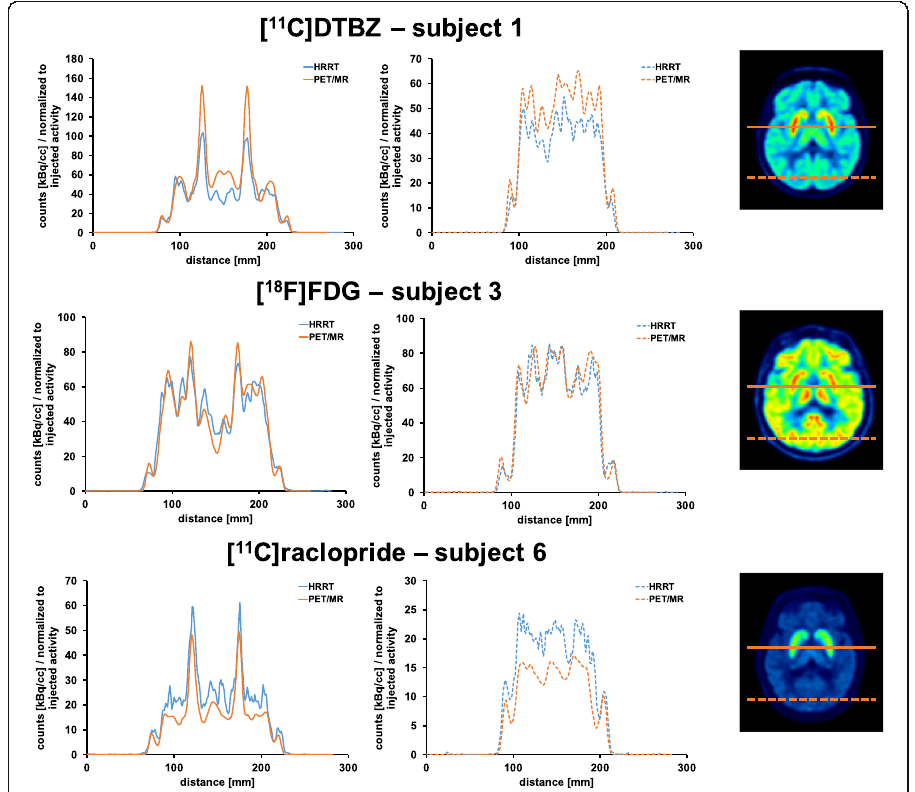
Fig. 8 Line profiles ([ 11 C]DTBZ, [ 18 F]FDG, [ 11 C]raclopride) of mean PET images. Profiles were normalized to the injected activity of each subject. Position of line profiles along the FOV (solid lines: typical target regions; dotted lines: typical reference regions) are illustrated on a representative slice of the mean [ 11 C]DTBZ, [ 18 F]FDG and [ 11 C]raclopride